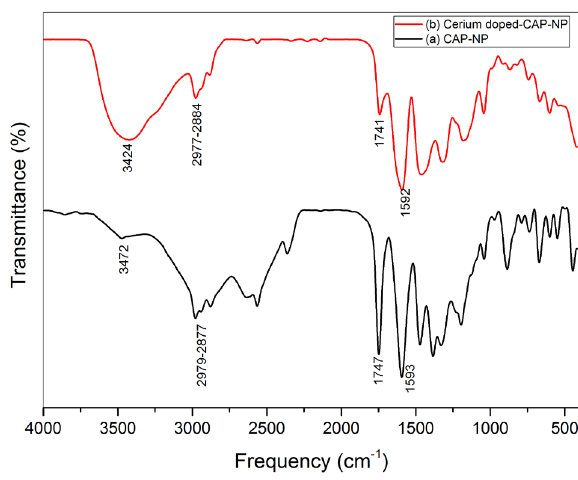
Figure 2 : FT- IR spectrum of a) CAP-NP and b) Ce 3+ doped CAP-NP.